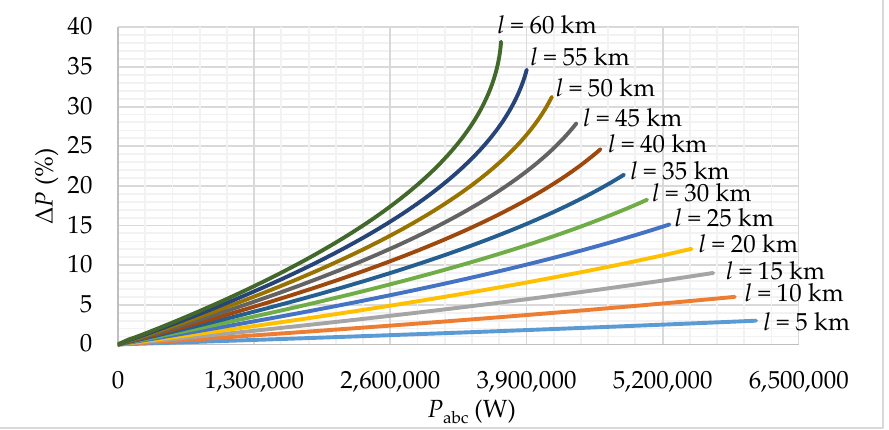
Figure 3. The dependence of increasing APL from three-phase active power consumption for ACSR 70/11 without consideration of voltage dip.